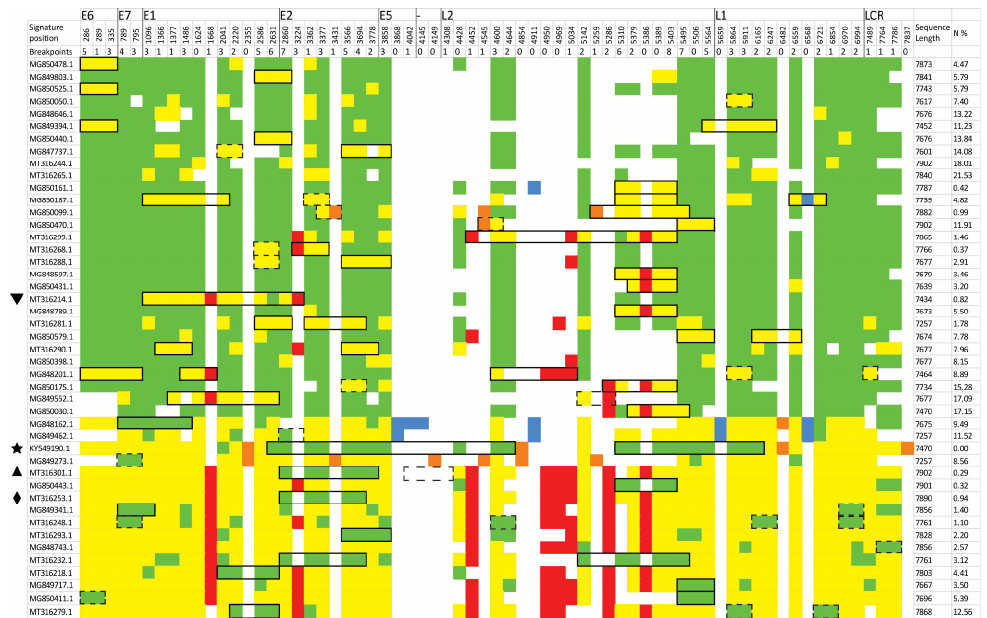
Figure 3. Lineage/clade-specific SNP distribution of the 45 putative recombinant sequences. Green squares correspond to A lineage SNPs, yellow to the BCD clade SNPs, orange to the C lineage SNPs and red to the D lineage SNPs. Thick blocks denote recombined regions of 3 or more consecutive SNPs of another lineage/clade, also referred as higher confidence recombination events. Dotted blocks denote lower confidence recombination events, that are supported by 2 or less lineage/clade specific SNPs. The SNP positions (on NC_001526) are shown in the second row. The number of times a SNP is found at the boundaries of a recombinant region is shown on the third row. This number provides a rough estimate of recombination frequency within a wider genomic region. The last column shows the percentage of unsequenced nucleotides in each genome. The triangles, star and diamond symbols denote the recombinant sequences identified also in the previous phylogenetic analysis of 180 complete representative genomes.